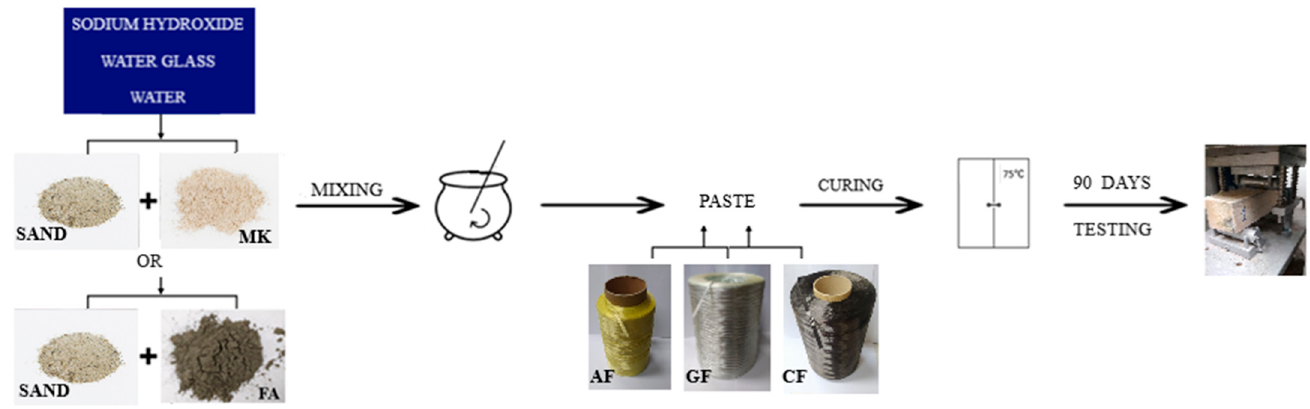
Figure 4. Scheme of sample preparation.